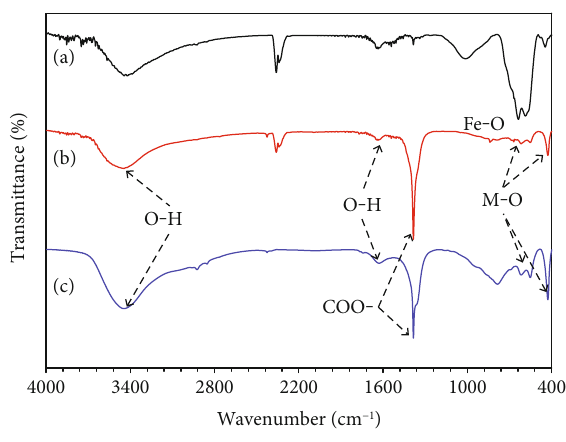
Figure 3: FT − IR spectrum of Fe